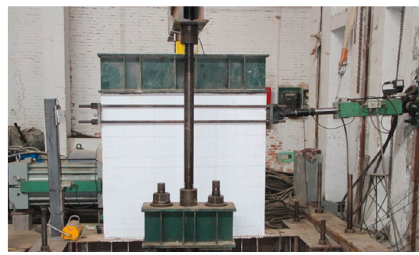
Figure 4: The picture of the test setup.